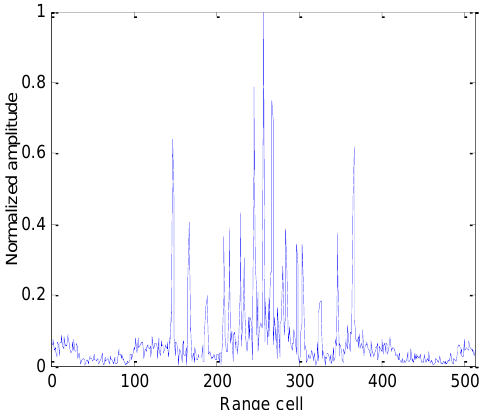
Figure 9. The 128th pulse’s range compression via integral cubic phase function-fractional Fourier transform (ICPF-FRFT).